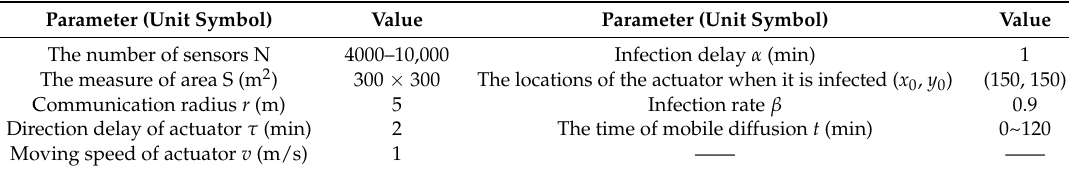
Table 1. The parameters of experiments.